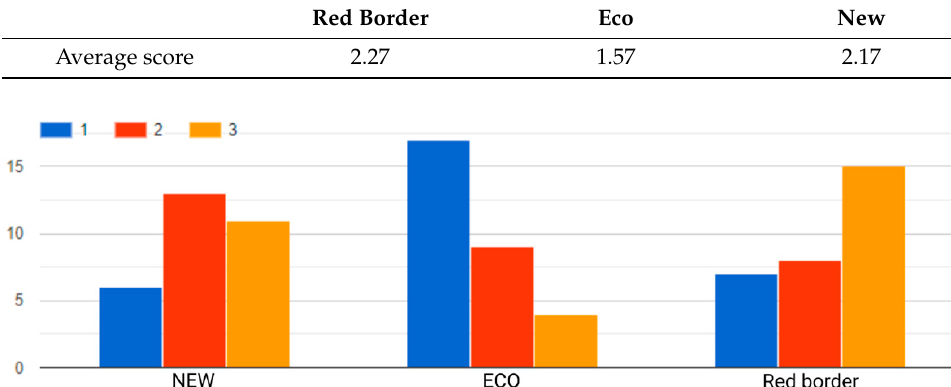
Table 3. Average number of points awarded by participants for each of the highlights. Red Border